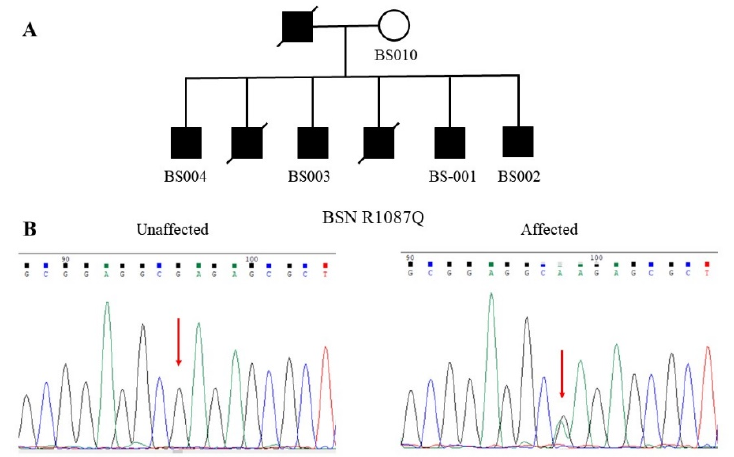
Figure 1. A multiplex family of schizophrenia with the R1087Q mutation of the BSN gene. ( A ) The pedigree shows the dominant inheritance of schizophrenia in this family. Only five members of this family were available for study. ( B ) Chromatograms show the wild-type G homozygote at the nucleotide position 49690249 of the BSN gene in the unaffected mother. At the same time, the other four patients carried the G-to-A heterozygous mutation of the BSN gene.